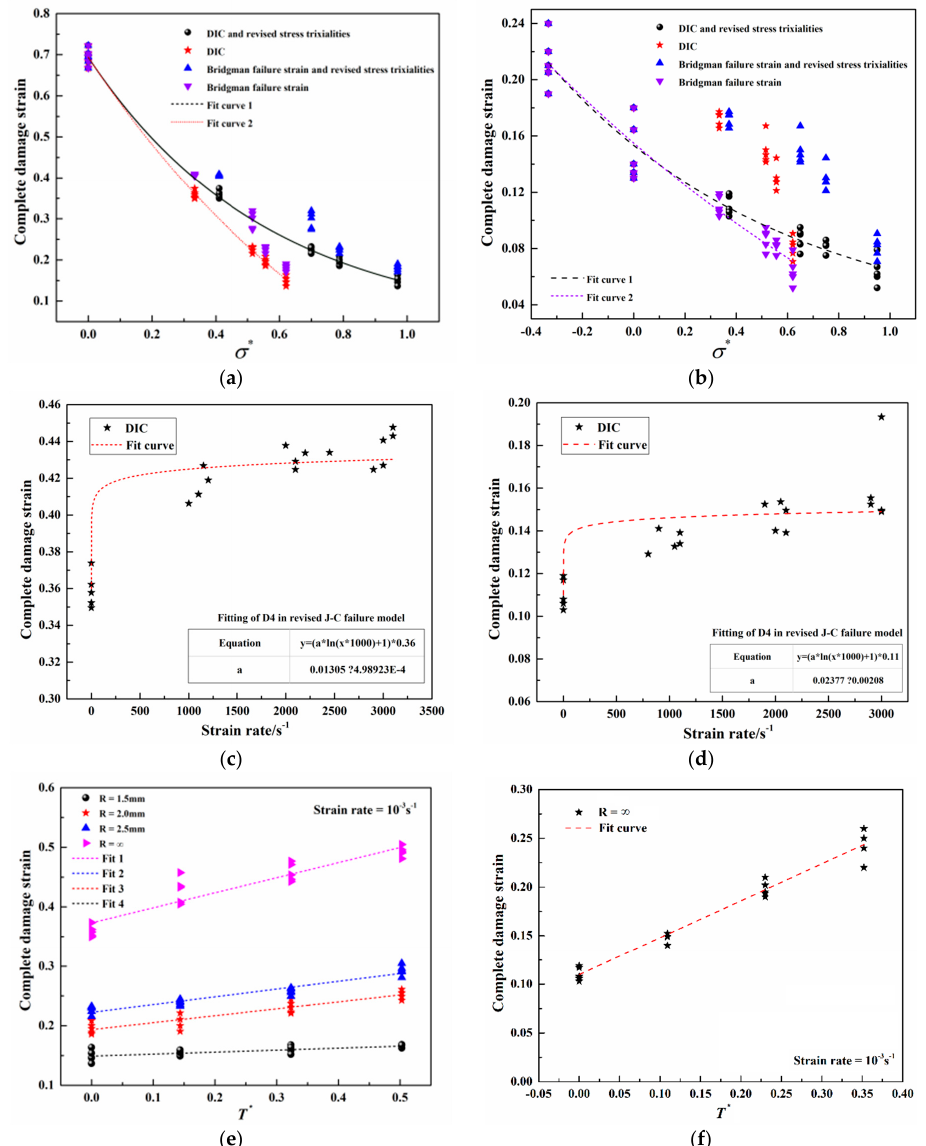
Figure 6. ( a ) Relationship between the complete damage strain and the revised stress triaxiality of the 2618 aluminum alloy; ( b ) relationship between the complete damage strain and the revised stress triaxiality of the Ti-6Al-4V titanium alloy; ( c ) relationship between the complete damage strain and the strain rate of the 2618 aluminum alloy; ( d ) relationship between the complete damage strain and the strain rate of the Ti-6Al-4V titanium alloy; ( e ) relationship between the complete damage strain and the temperature of the 2618 aluminum alloy; and ( f ) relationship between the complete damage strain and the temperature of the Ti-6Al-4V titanium